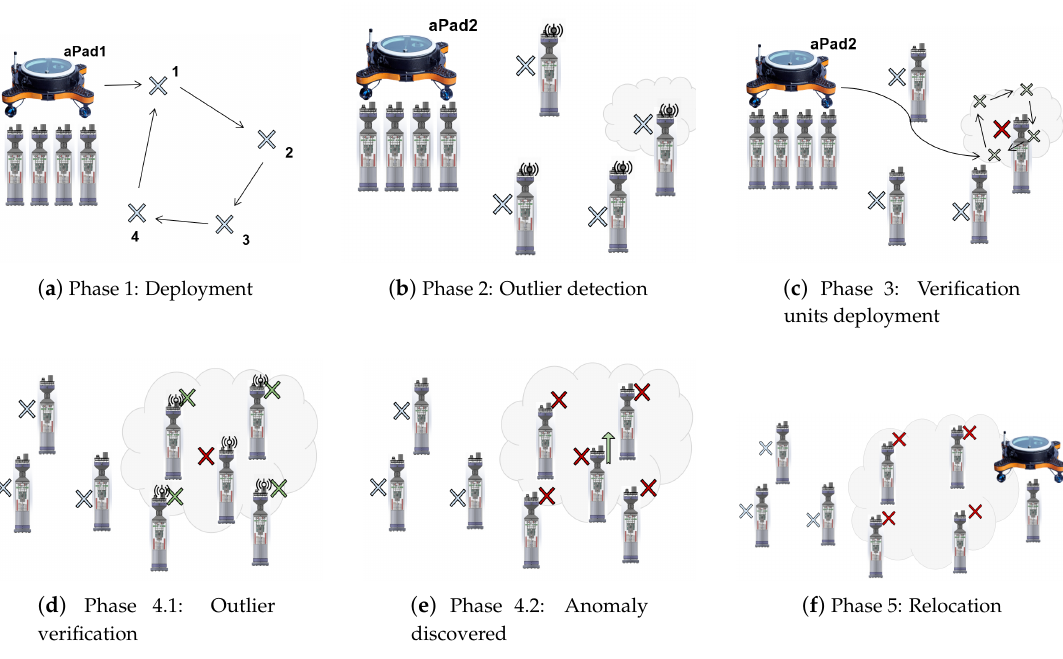
Figure 4. A graphical overview of the phases of the environmental monitoring scenario. ( a ) Exploration units deployment ( b ) Outlier detection ( c ) Verification units deployment ( d , e ) Outlier verification ( f )